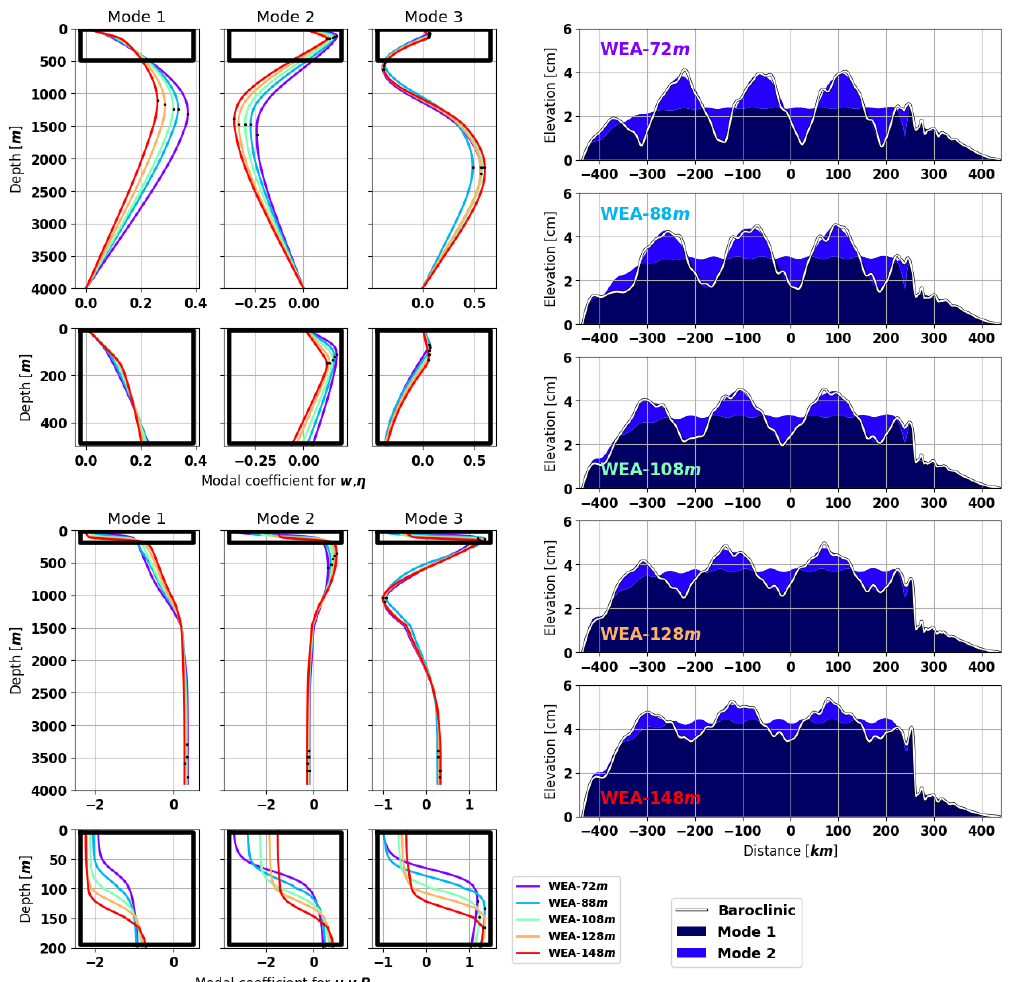
Figure 5. Baroclinic modal structures for the three first modes (left panels) and simulated amplitude of baroclinic surface elevation for the five first modes (right panel) for all the typical density profiles of the western equatorial Atlantic. The vertical modal structures are different for vertical processes ( w and η , upper left panels) and horizontal ones ( u , v and P , lower left panels). The black points show the extrema of the modes. The simulations are sorted with respect to the depth of the pycnocline. On the right panels, the white line represents the sum of the baroclinic modes and the colored patches represent the modal contribution to the complex sum: if the patch of mode n is located on top of the sum line, then mode n works against mode n −